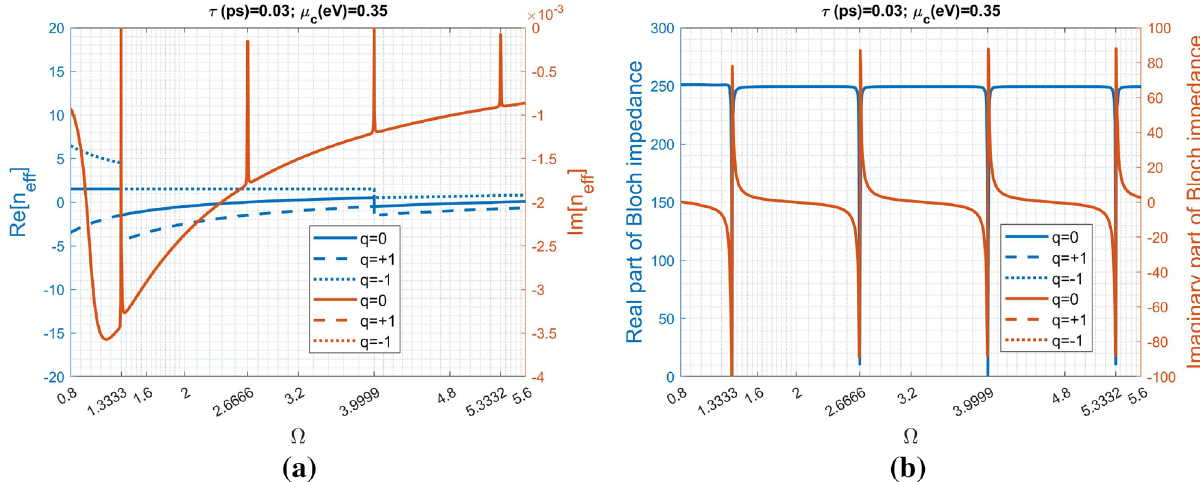
Figure 4. Effective refractive index and Bloch impedance against normalized angular frequency of the global view: ( a ) the real- and imaginary-parts of the effective refractive index ( n eff ), and ( b ) the real- and imaginary- parts of the Bloch impedance ( Z B